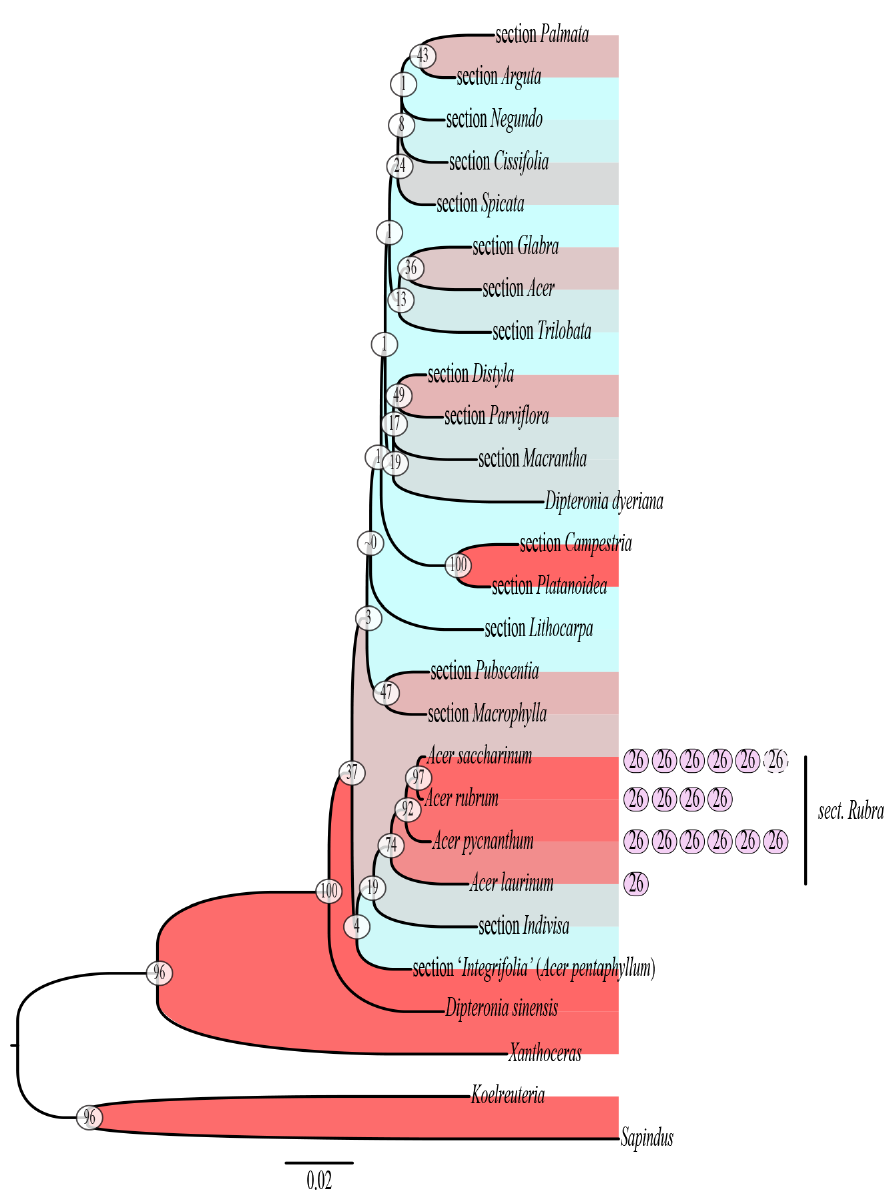
Figure 2. Maximum likelihood tree. Composite individuals represent sections except in the case of sects. Rubra and Hyptiocarpa , where composite individuals represent species. See Table 1 for GenBank accession numbers. Boostrap values for nodes are shown in white circles. Purple circles to the right of species in sects. Rubra and Hyptiocarpa represent one set each of 26 chromosomes (i.e., 2n=26) and show ploidy levels in sects. Rubra and Hyptiocarpa (e.g., A. saccharinum is tetraploid). Color coding of red and blue among branches shows relative support, respectively, from high (=100%BS) to low (~0%BS). Branches are scaled according to the bar below the